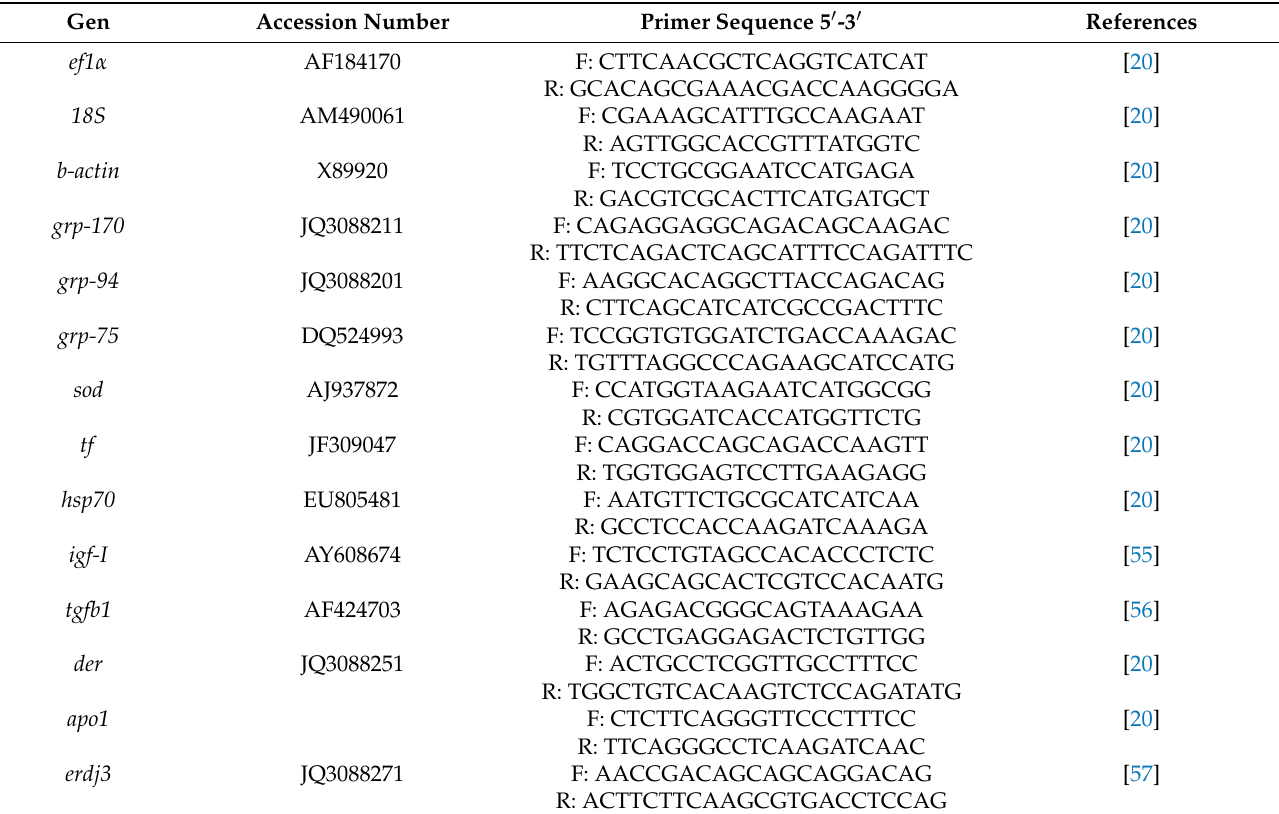
Table 1. Primers used for qPCR